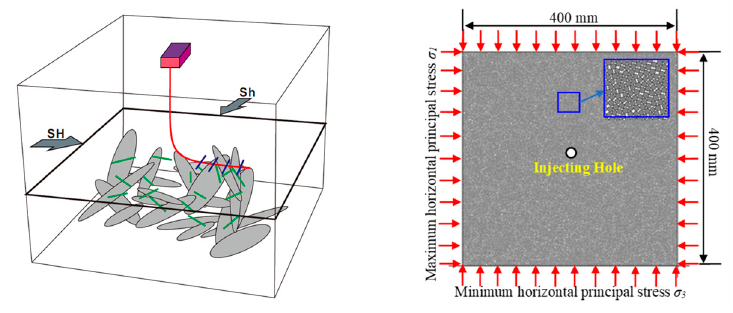
Figure 5. PFC 2D model prior to injection.